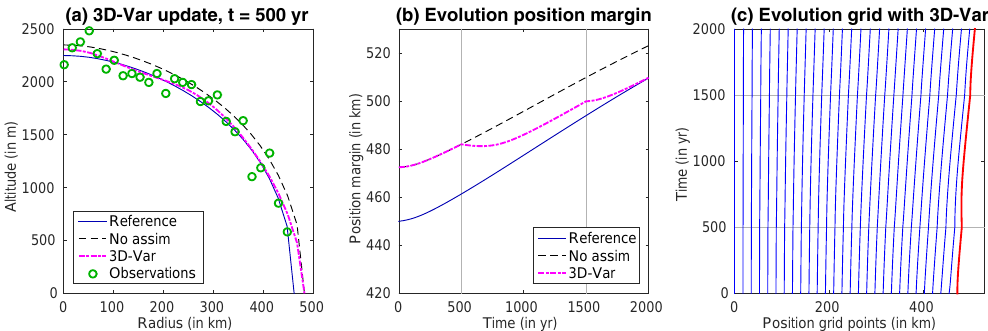
Figure 4. (a) 3D-Var analysis at time t = 500 years compared with the forecast and the reference when we update only ice thickness variables. The ice thickness profile is improved, especially between r = 100 and r = 400km. (b) Evolution of the position of the margin with time. Even if the position of the margin is not directly updated, the trajectory of the margin is corrected as a result of the ice thickness update. (c) Evolution of the position of grid points with time. The trajectory of each grid node is corrected after each analysis, as is the